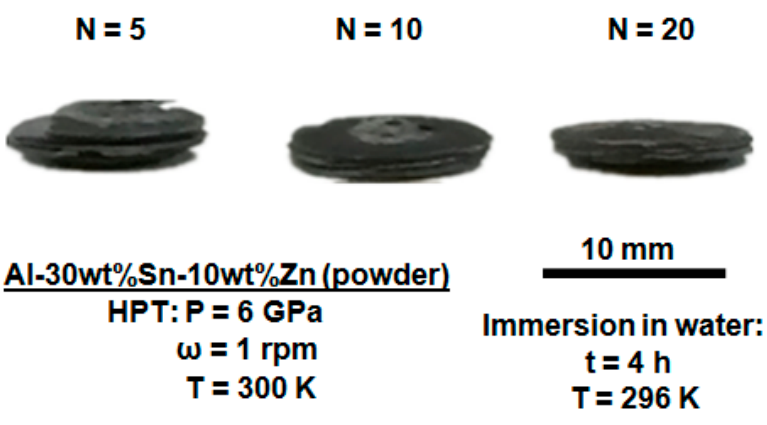
Figure 12. Appearance of Al-30wt %Sn-10wt %Zn discs after HPT processing of powders for N = 5, 10, and 20 and immersion in water at room temperature for 4 h.